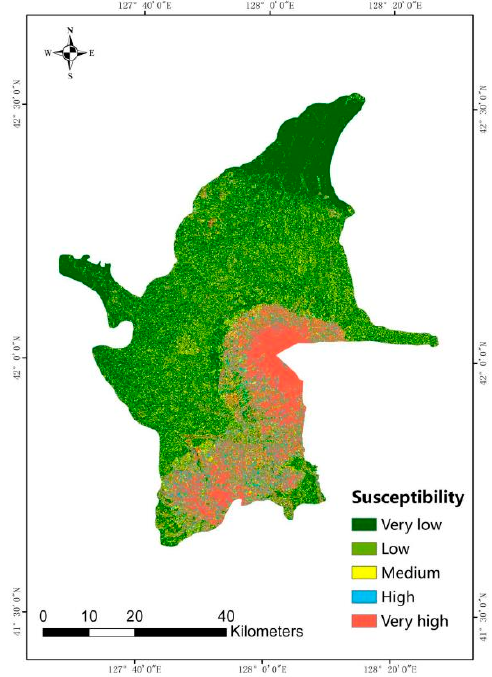
Figure 5. Earthquake-induced landslide susceptibility map . Table 4. Statistical table of prone zoning.